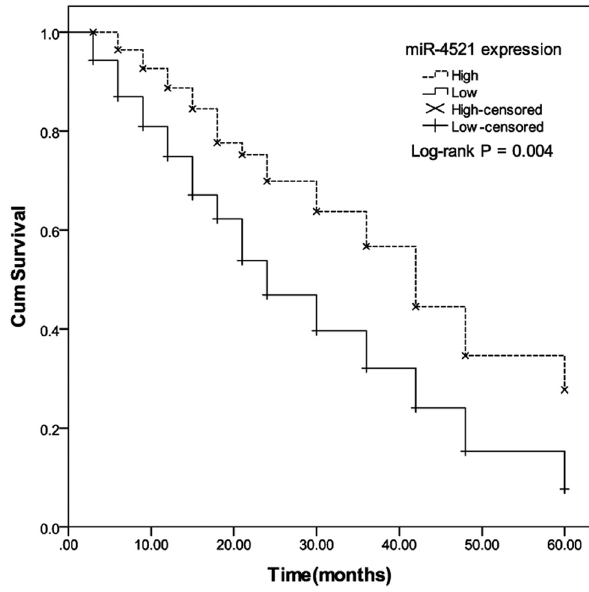
Figure 2: Survival curves of miR - 4521 high expression group and low expression group. The 5 year survival rate of the miR - 4521 high expression group was signi fi cantly higher than that of the low expression group ( log - rank test P = 0.004 ) .